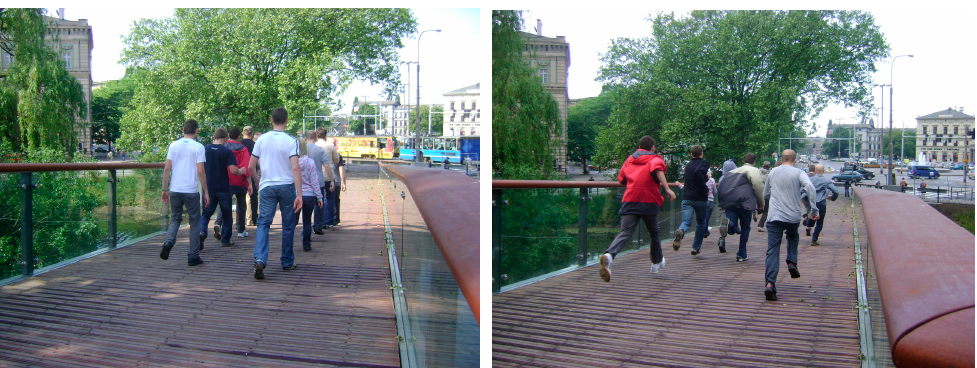
Figure 22. Examples of the dynamic tests carried out on the footbridge in Wroc ł aw (synchronized walking and running).